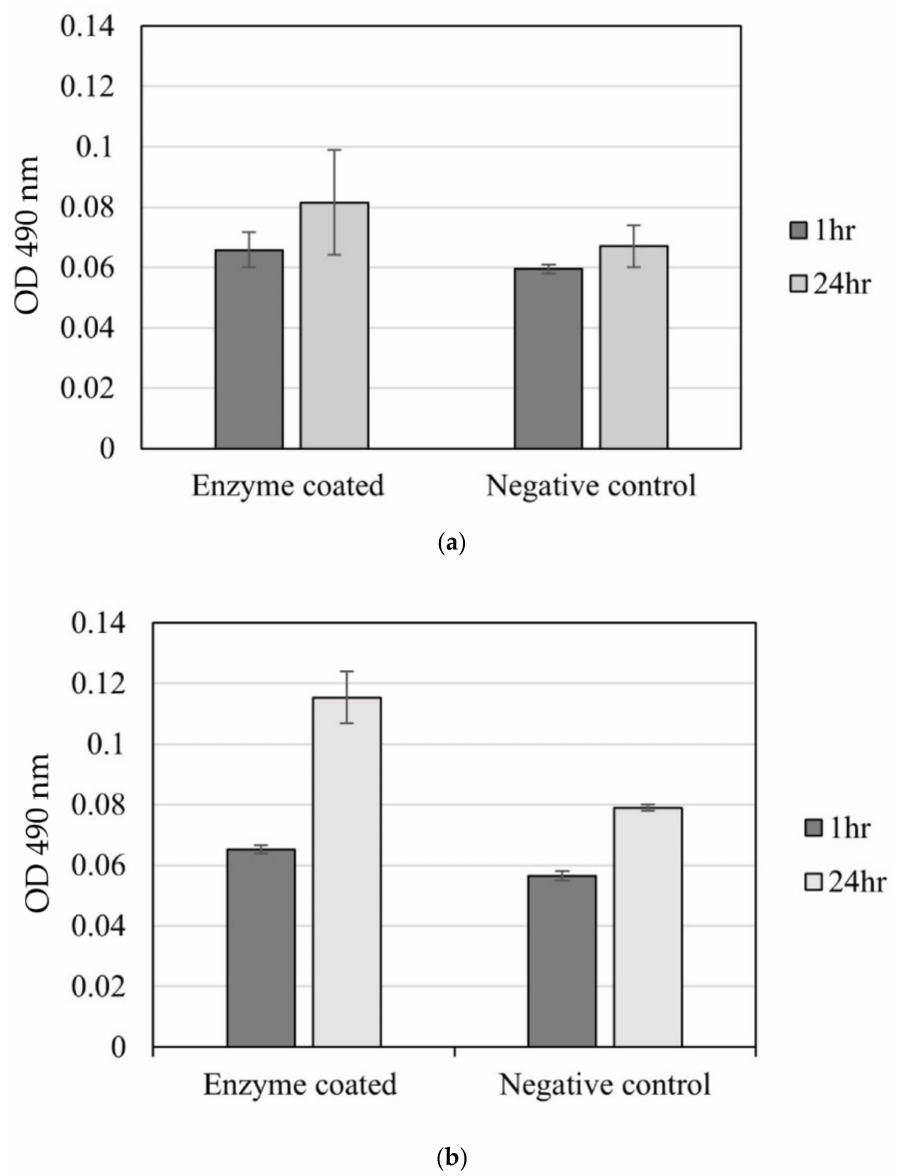
Figure 13. Activity results of GOx enzyme coated using ( a ) APTES-GA technique ( n = 5) and ( b ) APTES-(EDC/NHS) technique ( n = 5). Negative control: uncoated silicon